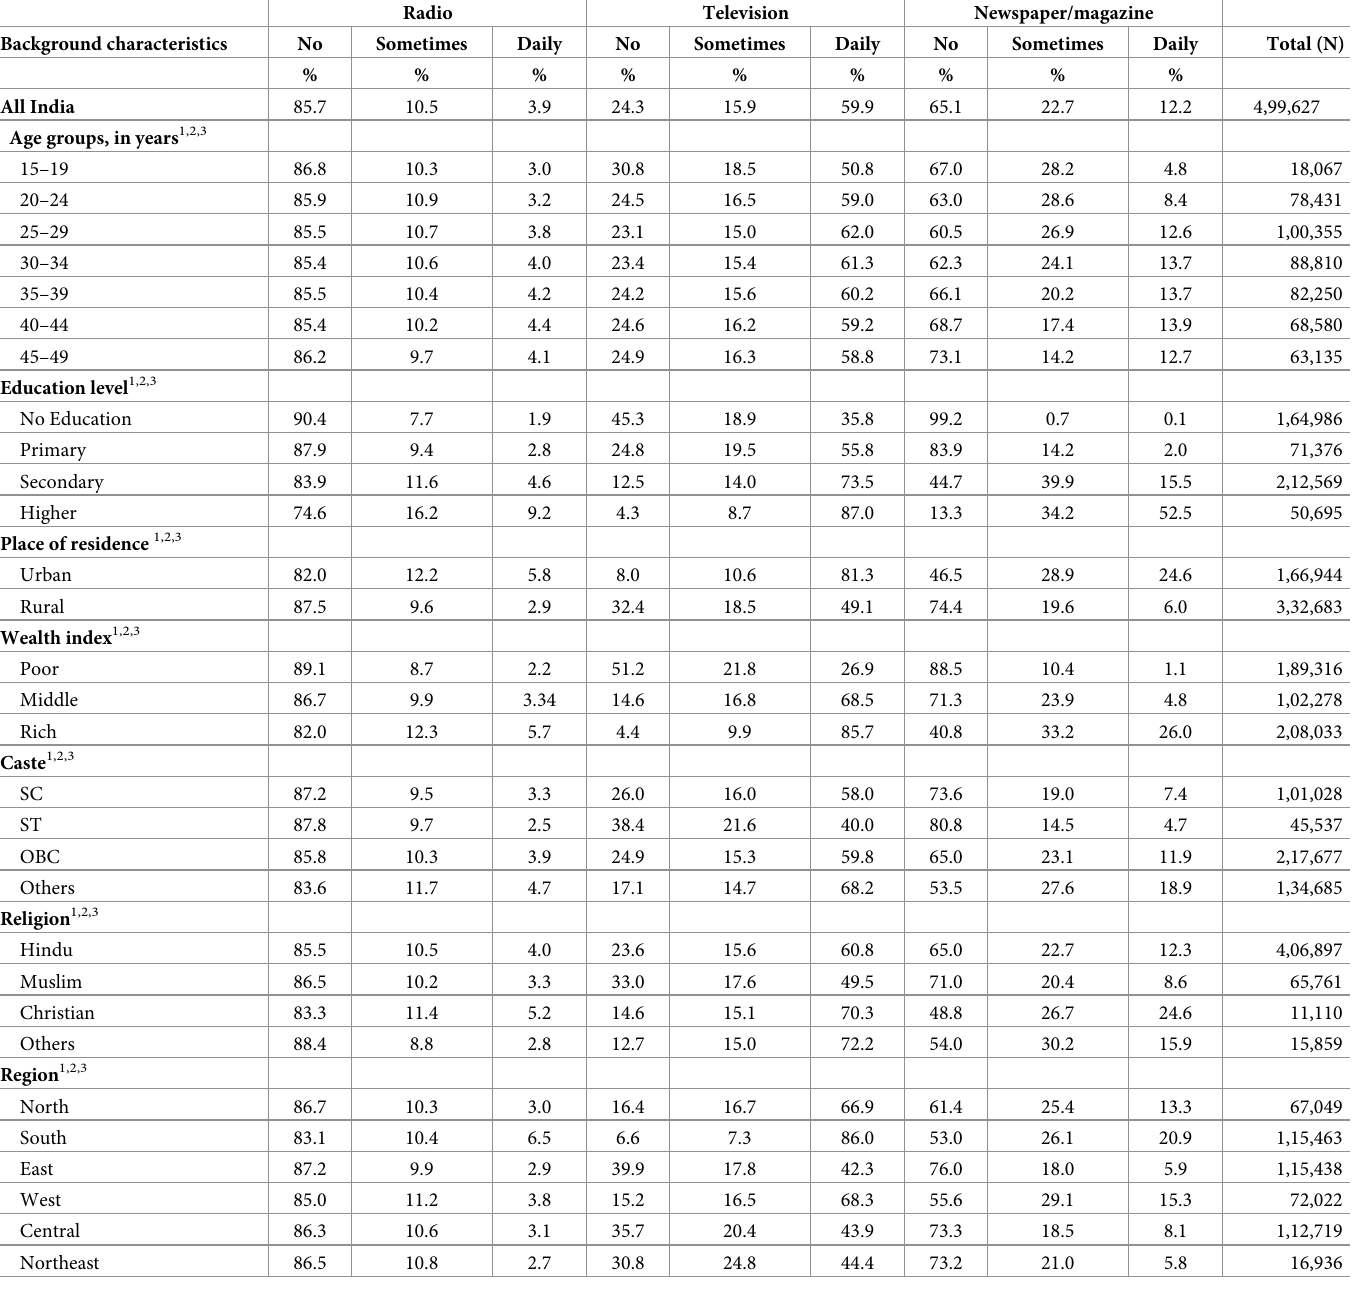
Table 1. Exposure to mass media by background characteristics for married women aged 15–49 years in India, NFHS